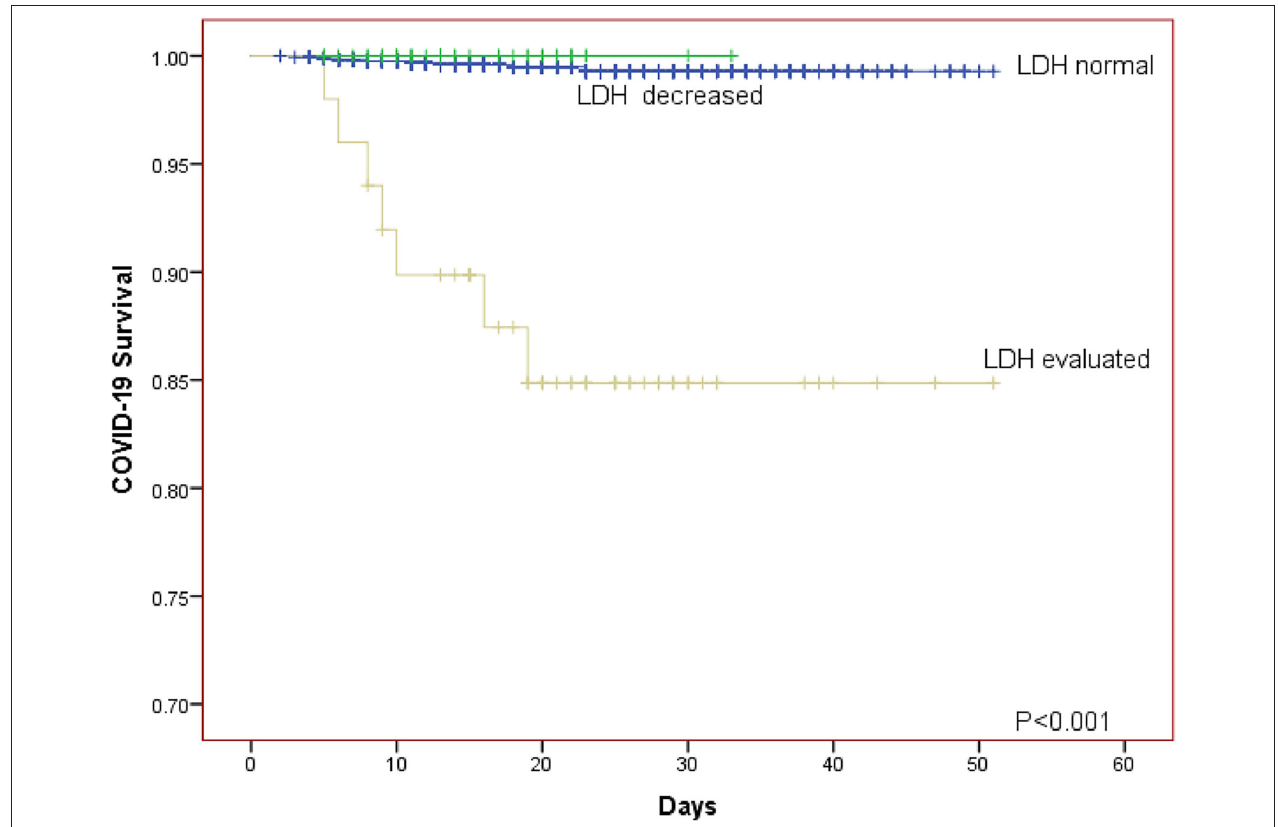
FIGURE 1 | The Kaplan-Meier curves for the survival of COVID-19 patients in different LDH level (normal group, decreased group, evaluated group).